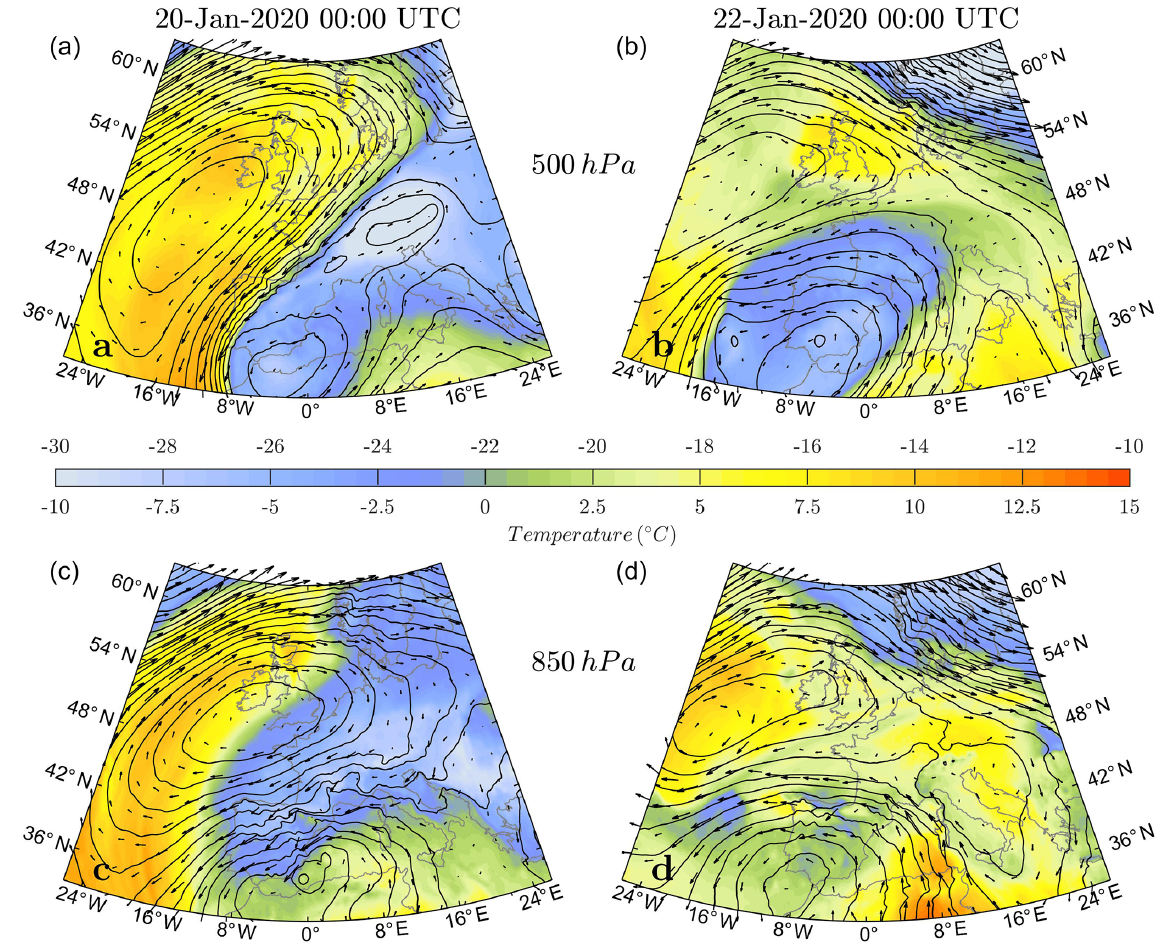
Figure 2. ECMWF analyses at 500hPa (a, b) and 850hPa (c, d) at 00:00UTC on 20 January (a, c) and 22 January (b, d) 2020. Black solid lines show the geopotential height, colours indicate the temperature, and wind speed is represented by arrows. Note the different temperature ranges for the 500hPa [ − 30 ◦ C, − 10 ◦ C] and 850hPa [ − 10 ◦ C, 15 ◦ C]